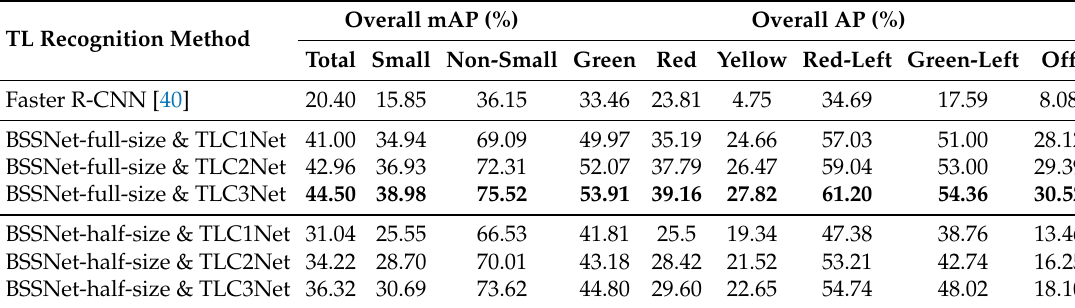
Table 3. TL recognition performances (overall mAP and overall AP) on test set.